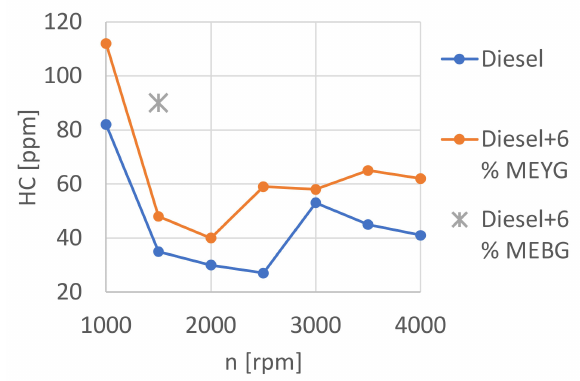
Figure 11. The HC emissions at full engine